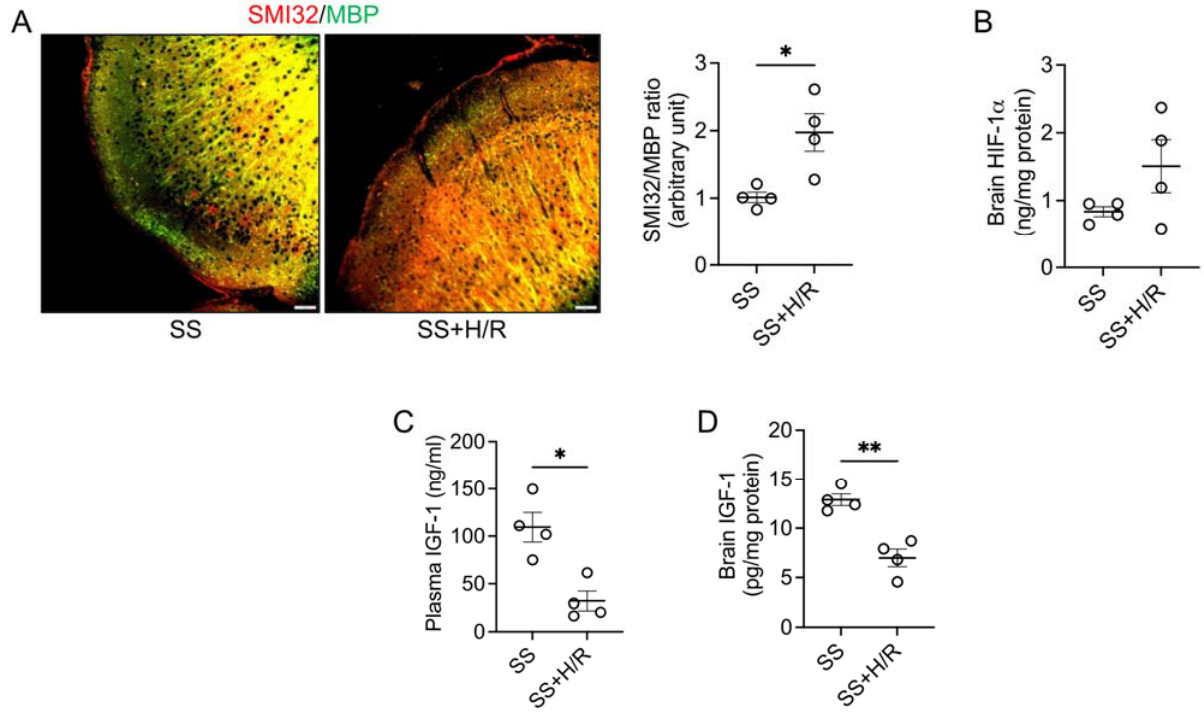
Figure 1. Hypoxia/Reoxygenation induced white matter injury is associated with reduced IGF-1 in sickle mice. ( A ) Sickle mice were either kept on room air (SS) or challenged with 7% oxygen for 2 h followed by 1 h of normoxia (SS+H/R). Representative immunofluorescence microscopic images showing merged SMI32 (red) and MBP (green) staining (scale bar = 50 μ m). The ratio of staining intensity of SMI32 and MBP indicates white matter injury in the SS+H/R mice compared to SS mice ( n = 4). ( B ) Total HIF ‐ 1 α protein levels were measured in brain tissue homogenates from SS and SS+H/R mice. HIF ‐ 1 α was induced following H/R challenge ( n = 4). ( C , D ) Total IGF ‐ 1 levels in plasma ( C ) and brain tissue ( D ) were reduced in the SS mice after H/R ( n = 4). * p < 0.05 and ** p < 0.01.